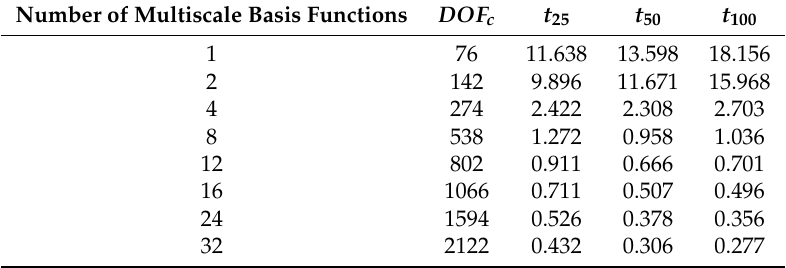
Figure 10. Numerical results for Test 2.DBC . Solutions p and p ms for different times: t 25 , t 50 , and t 100 (from left to right). First row: Fine-scale solution DOF f = 13,760. Second row: Multiscale solution using 16 basis functions DOF c = 1066. Table 4. Numerical results for Test 2.DBC . Relative L 2 error (%) for different numbers of multiscale basis